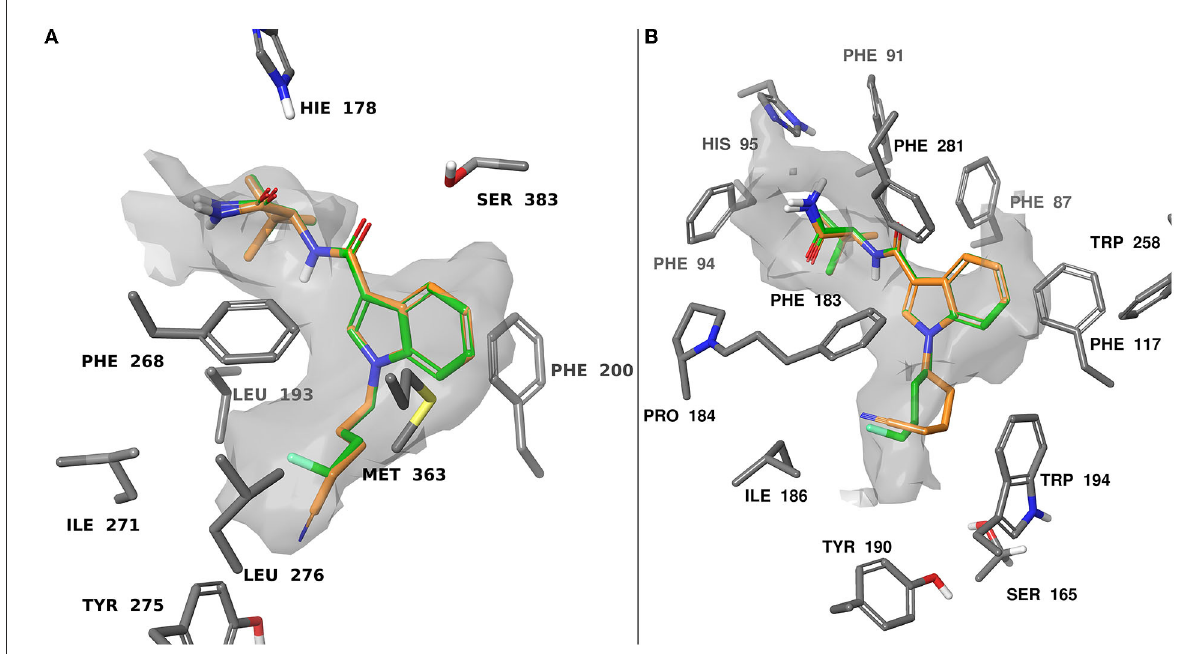
FIGURE5 Computationally predicted binding modes of 9 (orange) and 26 (green) overlayed at CB 1 (A) , PDB:6N4B and CB 2 (B) , PDB:6PT0 (57, 58). The hydrophobic regions of the binding site (grey) were evaluated with SiteMap (67). Glide docking was performed using the Schrodinger computational chemistry suite